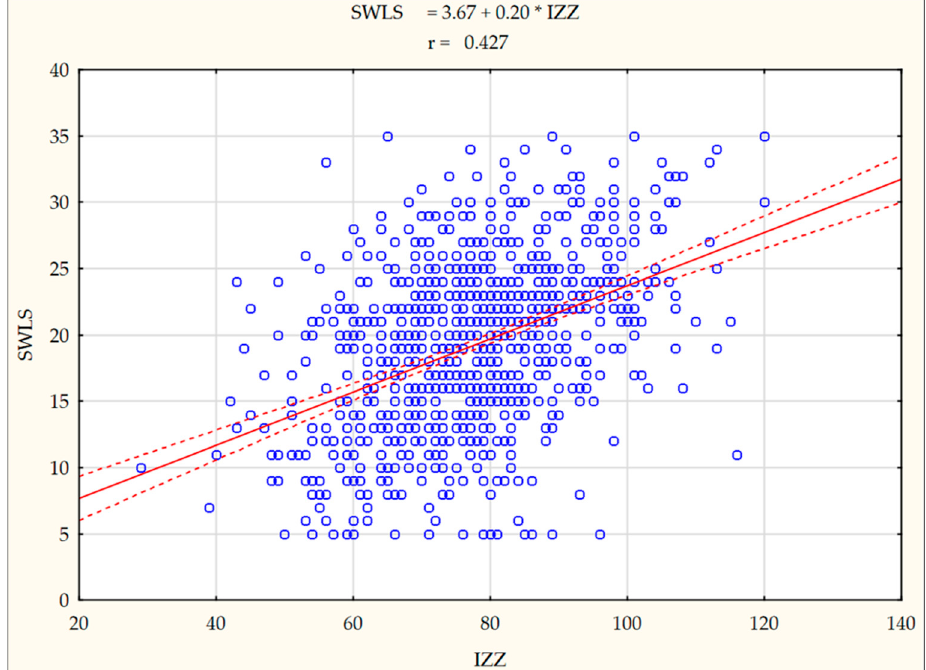
Figure 2. The character and intensity of the correlation between satisfaction with life and health behaviours from a general perspective among the study participants—Pearson correlation coefficients (r). Abbreviations: SWLS—Satisfaction With Life Scale, IZZ—Health Behaviour Inventory, Solid red line—straight line of the linear regression SWLS = 3.67 + 0.20* IZZ, Dotted red line—line of the regression strip with a confidence interval at 0.95.